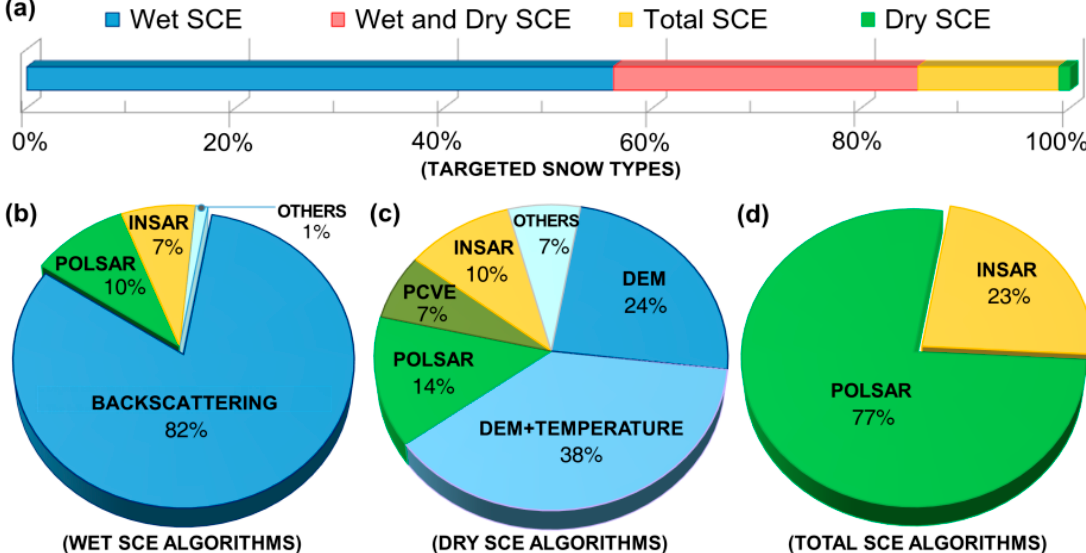
Figure 9. Overview of targeted snow types and corresponding algorithms. ( a ) Targeted snow types and employed algorithms for ( b ) wet ( c ) dry ( d ) total snow cover extent (SCE).